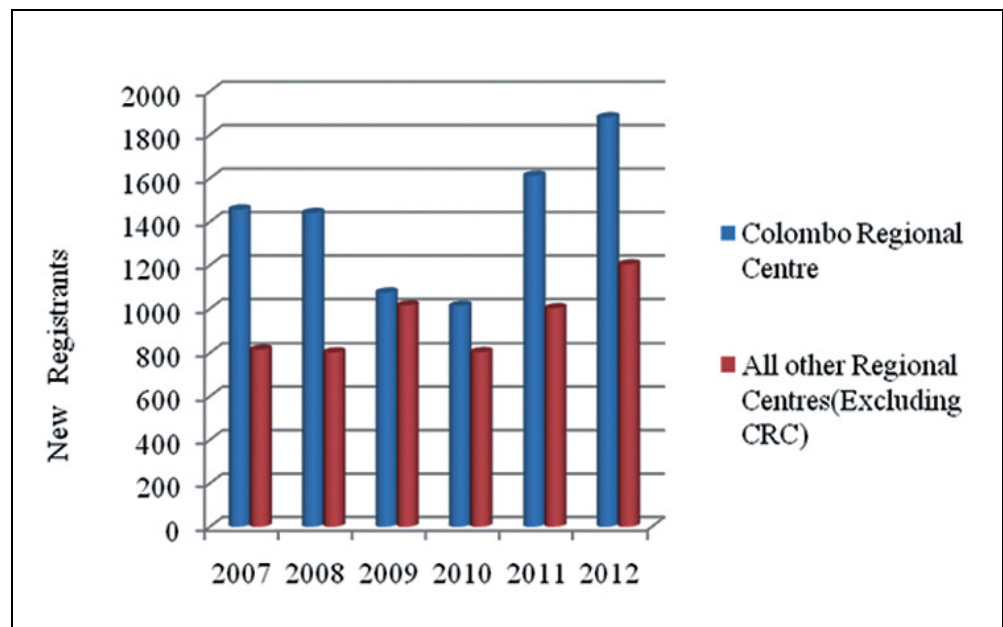
Figure 1 New registrants from 2007 – 2012 Colombo vs. other regional